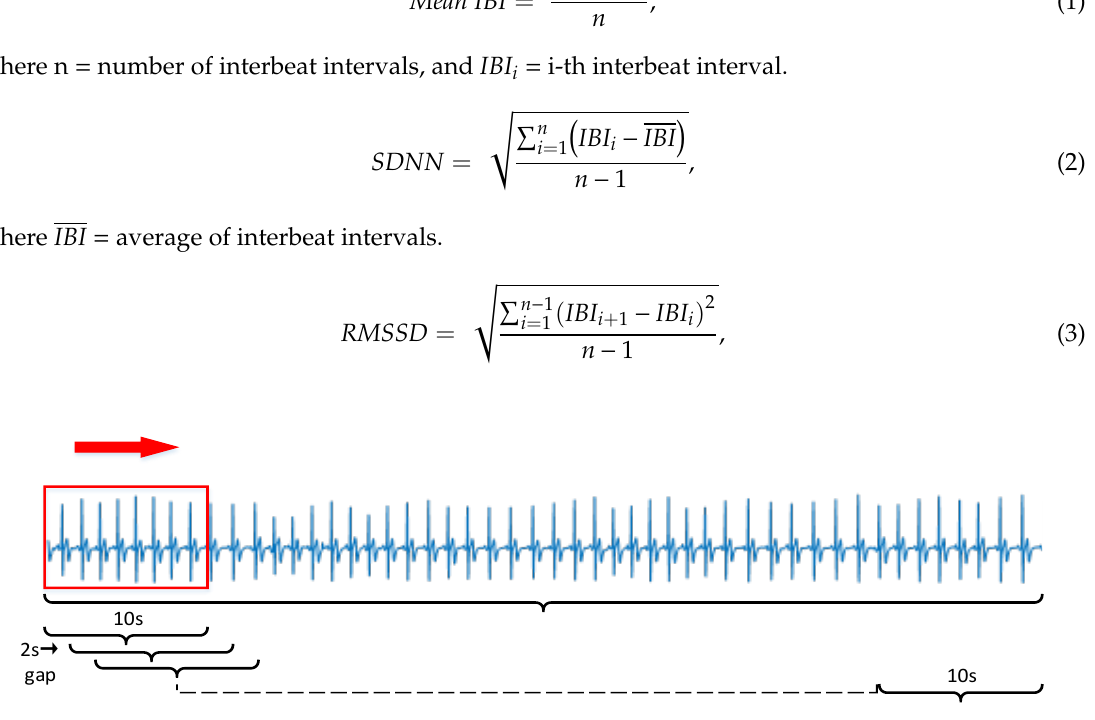
Figure 6. Data segment for ANN model.